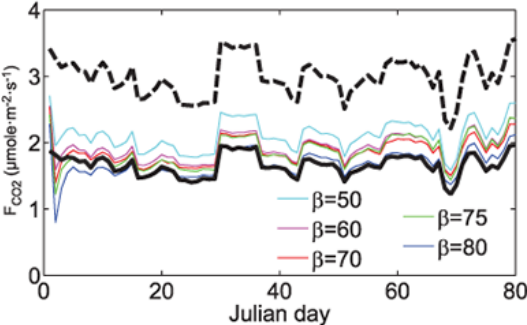
Figure 12. Time series of daily mean CO 2 fluxes averaged in do- main I (shown in Fig. 9a) from 1 January to 20 March 2010 with the inflation factor of scaling factors β = 50 , 60 , 70 , 75 and 80. The black dashed line is the time series averaged from F ∗ t and the black solid line is the time series averaged from F p t